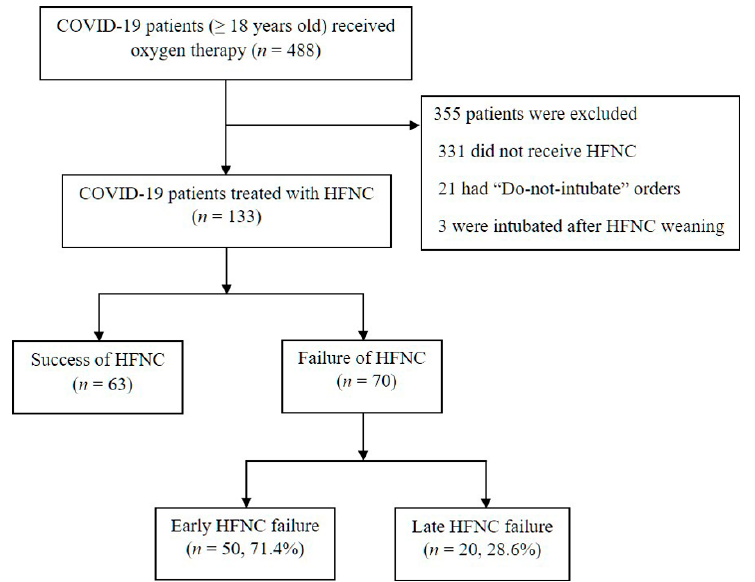
Figure 1. Study flow chart. COVID-19 = coronavirus disease 2019, HFNC = high-flow nasal cannula. Failure of HFNC was defined as the need for mechanical ventilation despite HFNC application: early failure (within 48 h) and late failure (after 48 h).